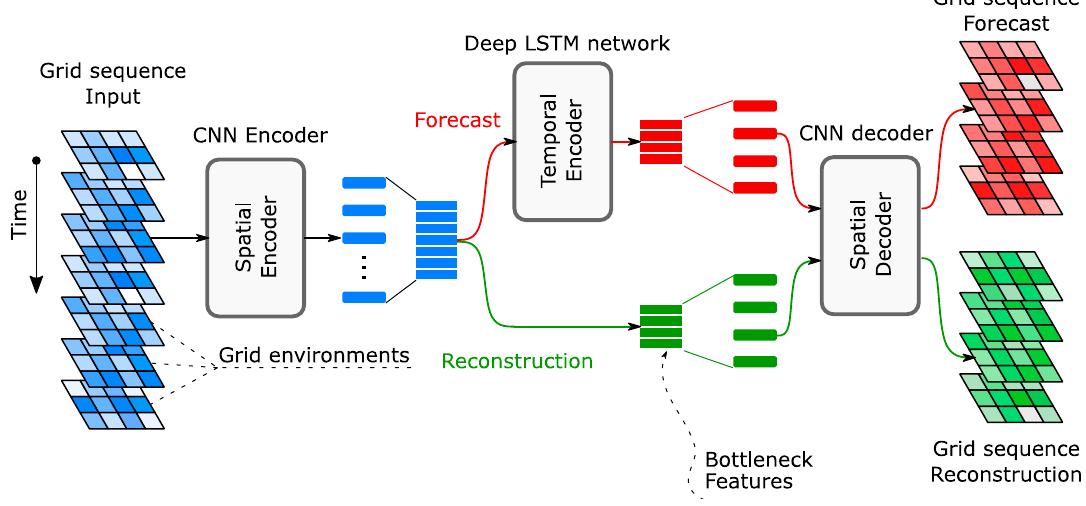
Figure 15. The spatiotemporal composite autoencoder network [58].